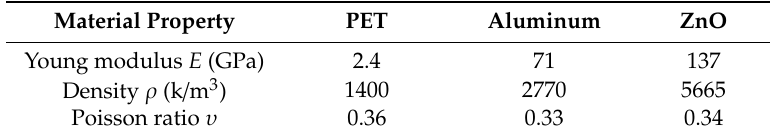
Table 3. Properties of the piezoelectric nanogenerator used in the analytical and finite element method (FEM) models [44].